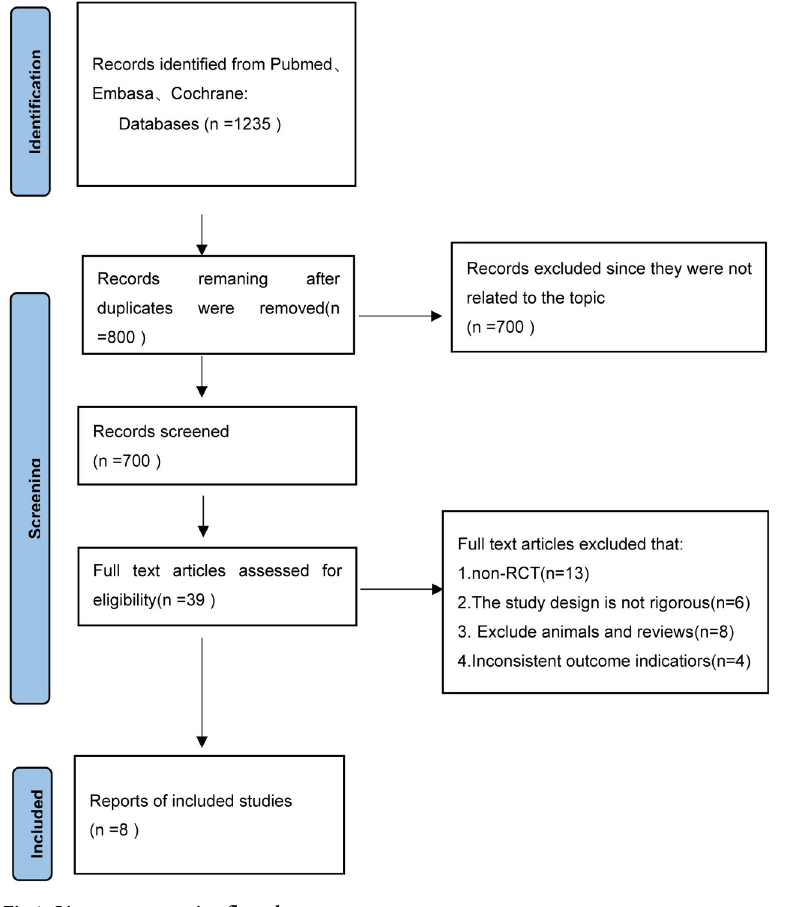
Fig 1. Literature screening flow